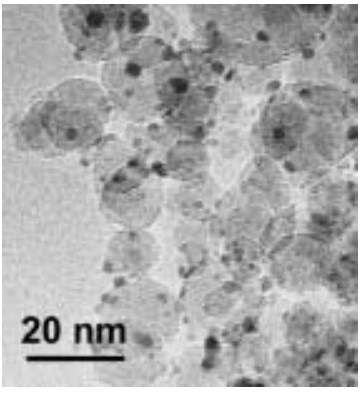
Fig. 4 HRTEM-image of 7.5 wt% Pt on open structured-alumina made by the single-step flame spray pyrolysis (courtesy of R. Strobel, adapted from Strobel et al.